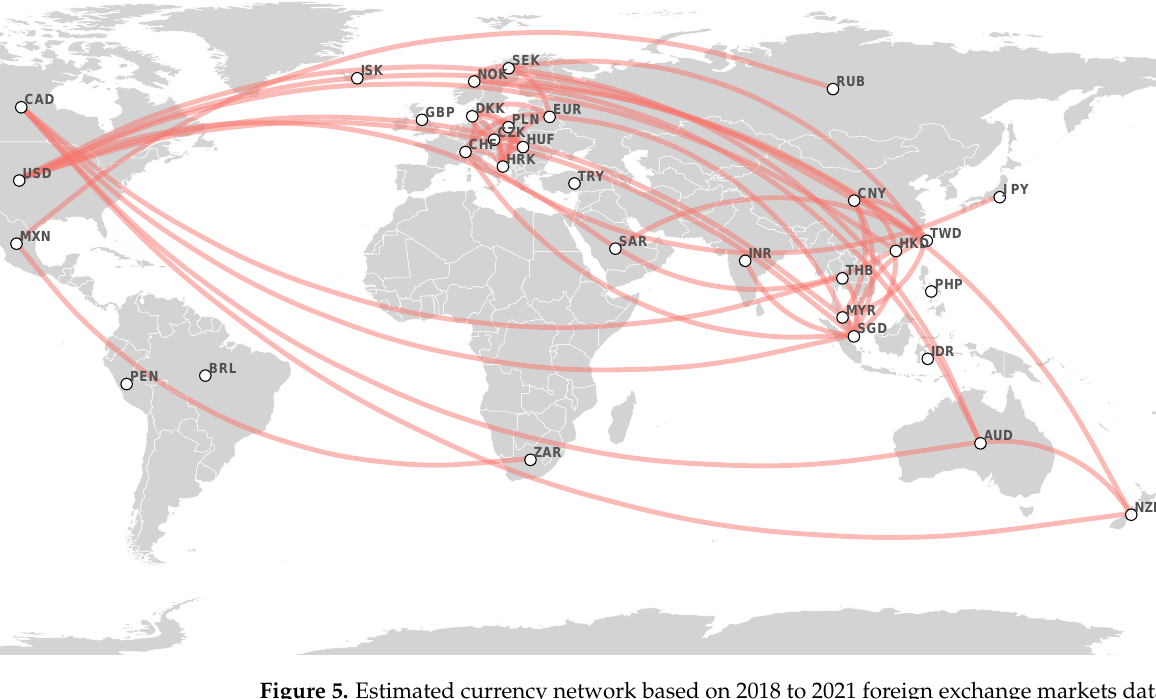
gray Figure 5. Estimated currency network based on 2018 to 2021 foreign exchange markets